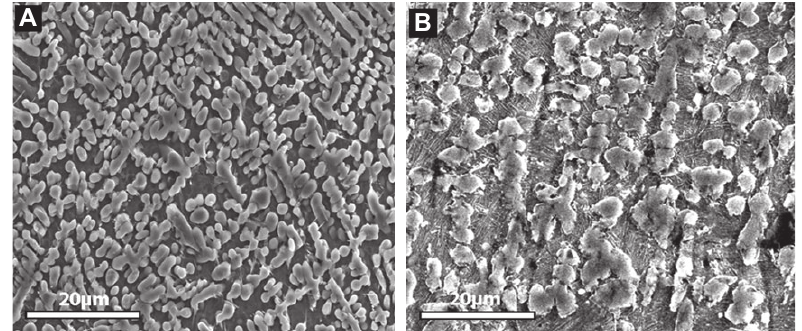
Figure 4 SEM micrographs of the alloying coating in sample 3. (A) Middle coating, (B) upper